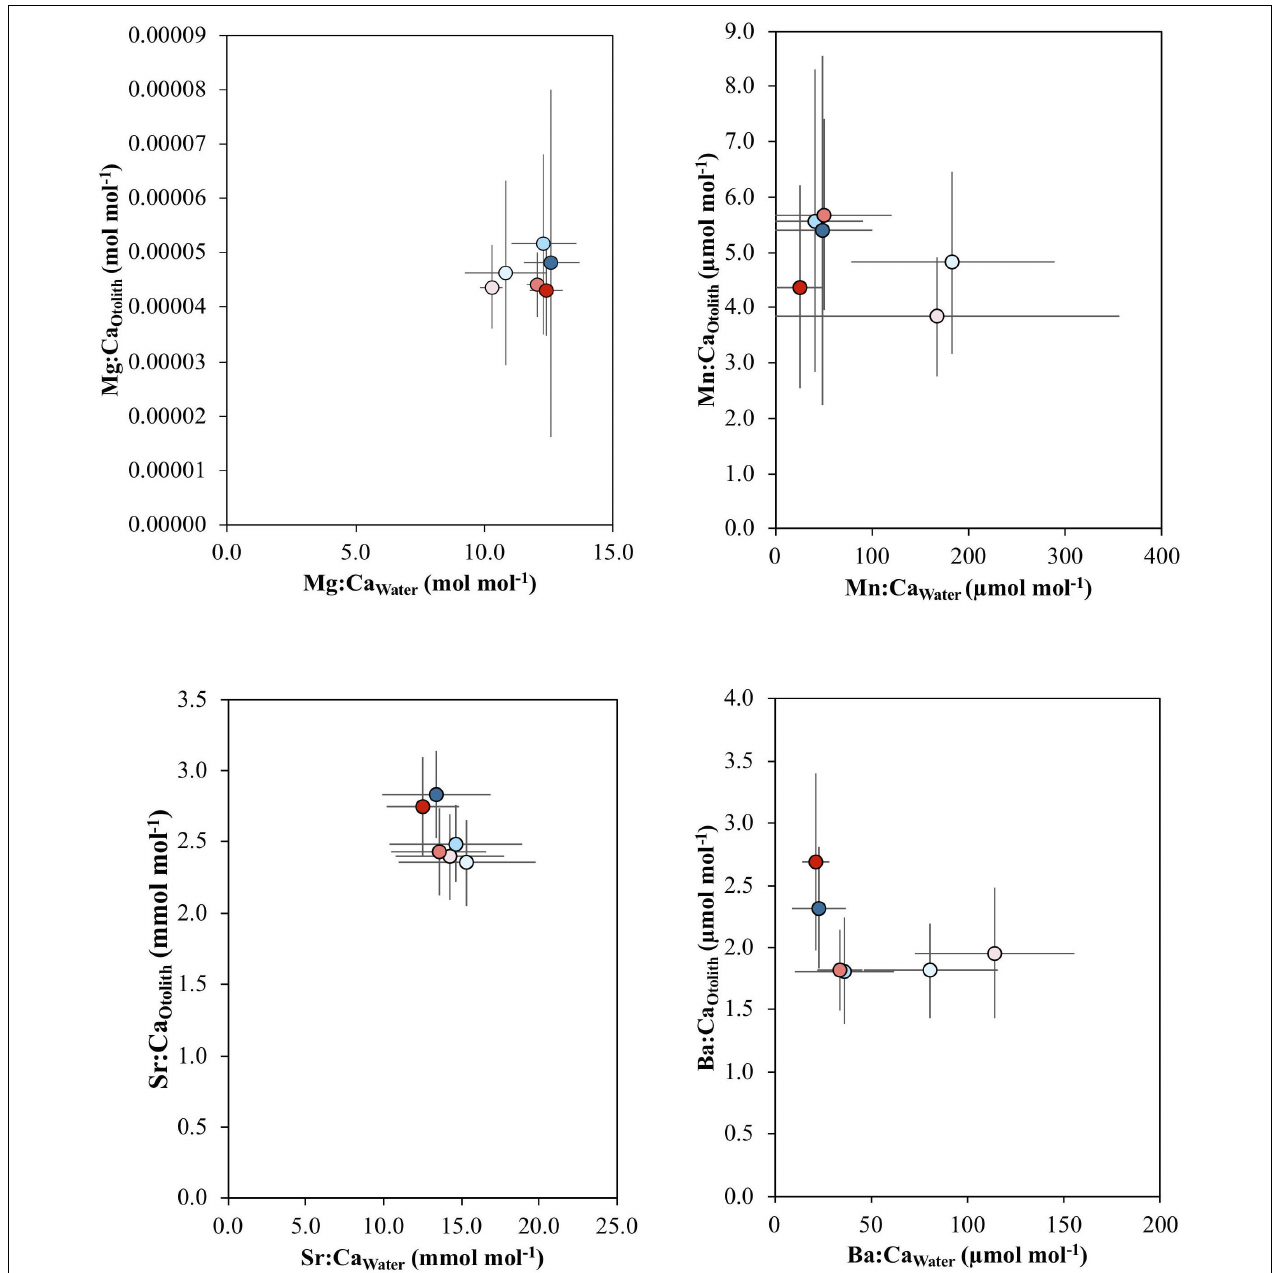
FIGURE 4 | Mean and standard error of the relationship between Mg:Ca Otolith and Mg:Ca Water , Mn:Ca Otolith and Mn:Ca Water , Sr:Ca Otolith and Sr:Ca Water , and Ba:Ca Otolith and Ba:Ca Water across the salinity (5, 18, 30) and temperature (16 and 21 ◦ C) experimental treatments, which are indicated by the different colors: blue colors – 16 ◦ C, red colors – 21 ◦ C; light tone – 5 salinity, medium tone – 18 salinity, dark tone – 30